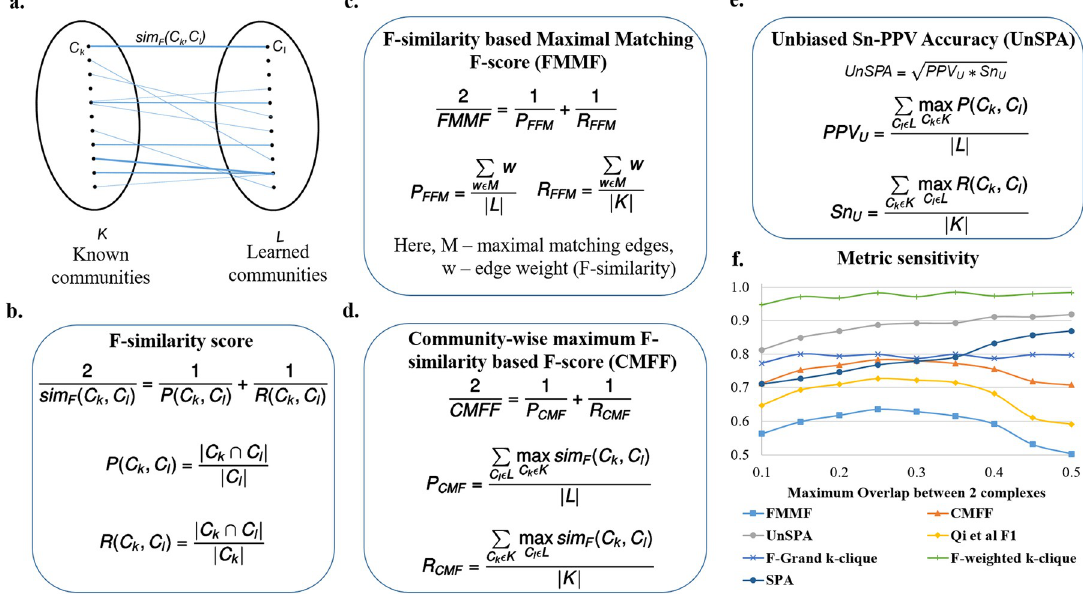
Fig 3. Proposed evaluation measures—FMMF, CMFF, and UnSPA are sensitive metrics. a. Bipartite graph, where each edge weight corresponds to the F-similarity ( sim F ( C k , C l )) between C k , a known community from K , the set of known communities and C l , a learned community from L , the set of learned communities. b . The F-similarity score combines precision ( P ( C measures, computed as fractions of the number of common nodes w.r.t the number of nodes in a community. | C | is the number of nodes in community C and | C 1 \ C 2 | is the number of nodes common to both communities. c. F-similarity-based Maximal Matching F- score (FMMF) combines precision ( P FFM ) and recall ( R FFM ) measures computed for a maximal matching, M of the bipartite graph in Fig 3A d. Community-wise Maximum F-similarity based F-score (CMFF) combines precision ( P